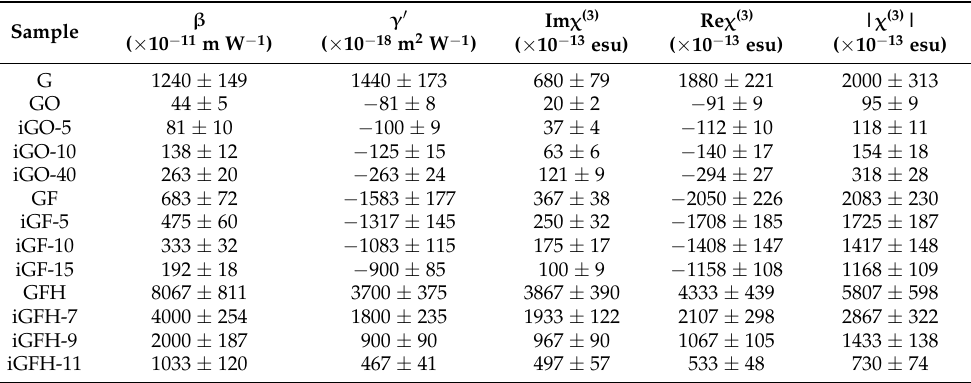
Table 1. NLO parameters of G, GO, GF and GFH before and after UV irradiation. All values refer to a concentration of 1 mg mL − 1 .